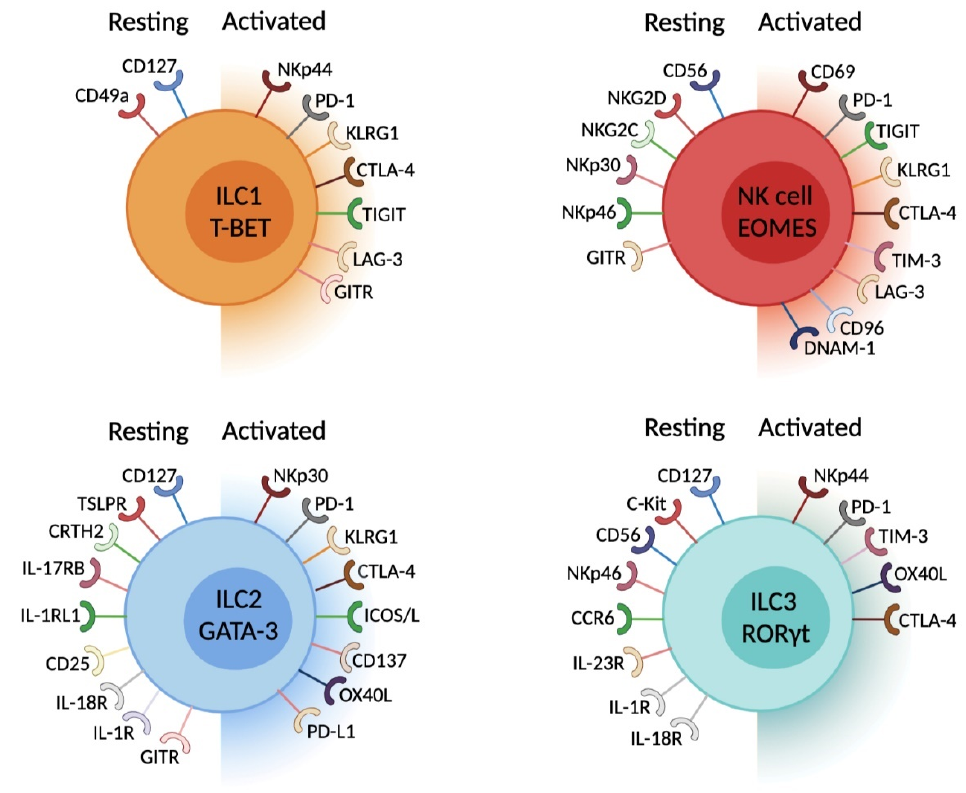
Figure 2. Cytokine and chemokine receptors and IC expression on mouse or human ILC according to their activation status. This figure has been created with BioRender.com.